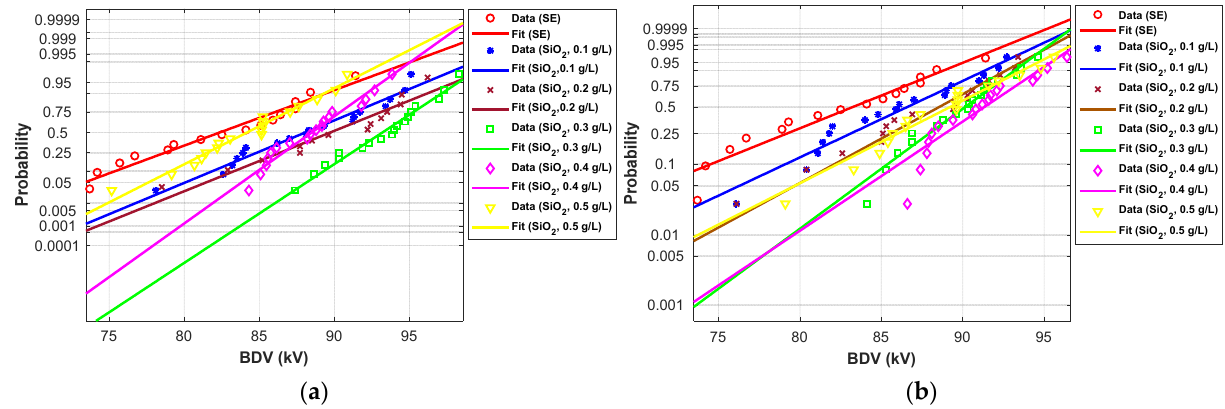
Figure 19. Probability plot of breakdown voltage data of SE-based nanofluids with SiO 2 (10–20 nm) for 2.5 mm electrode gaps; ( a ) normal and ( b ) extreme value.